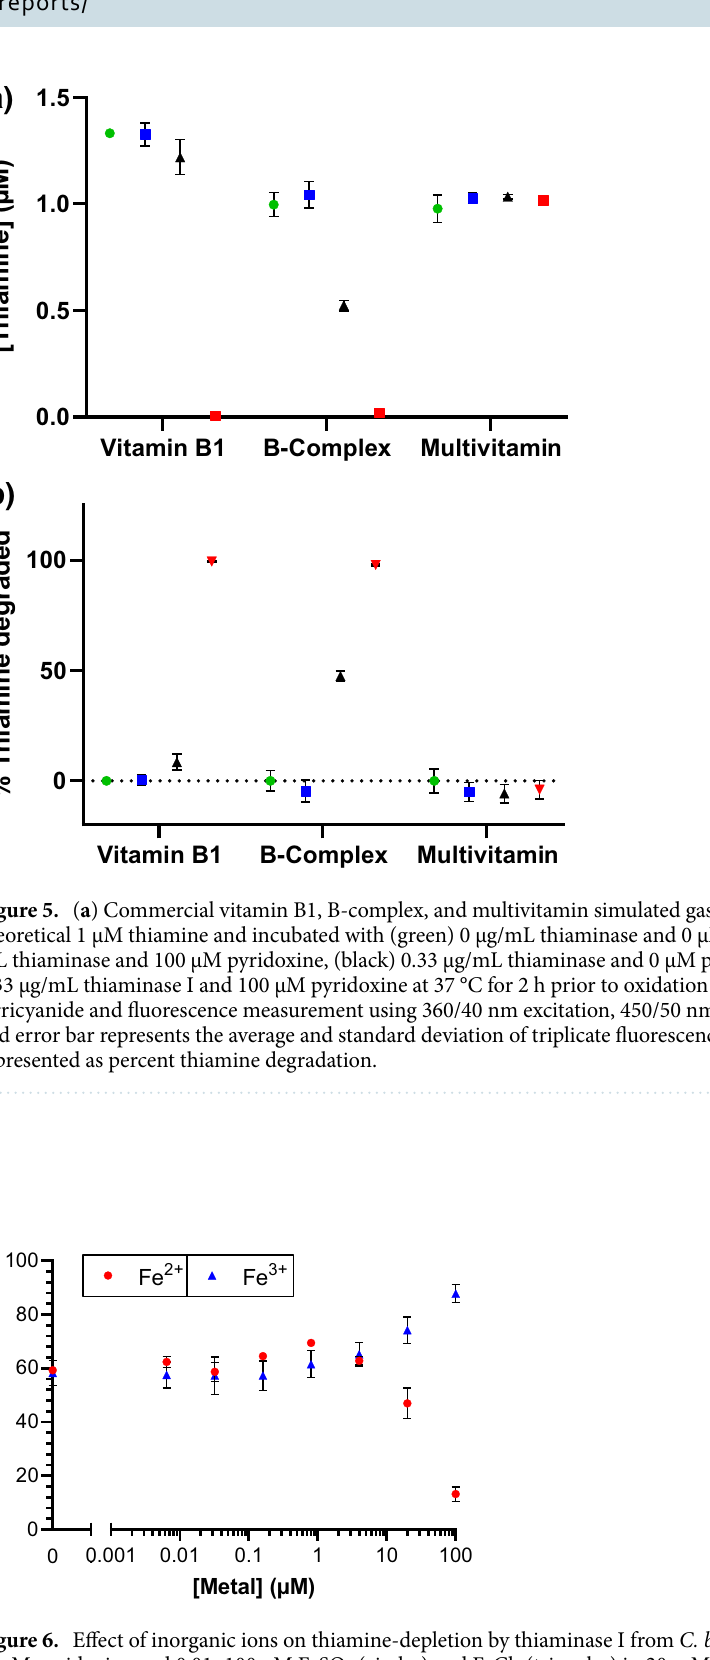
Figure 6. Effect of inorganic ions on thiamine-depletion by thiaminase I from C. botulinum. 10 µM thiamine, 1 mM pyridoxine and 0.01–100 µM FeSO 4 (circles) and FeCl 3 (triangles) in 20 mM MES/20 mM NaCl, pH 6.5 were incubated in the presence and absence of 0.33 µg/mL thiaminase I at 37 °C for 1 h. 5 µL of the reaction mixture was diluted with 45 µL water, then 100 µL alkaline potassium ferricyanide was added prior to measurement using 360/40 nm excitation, 450/50 nm emission. The results are reported as the percent of thiamine